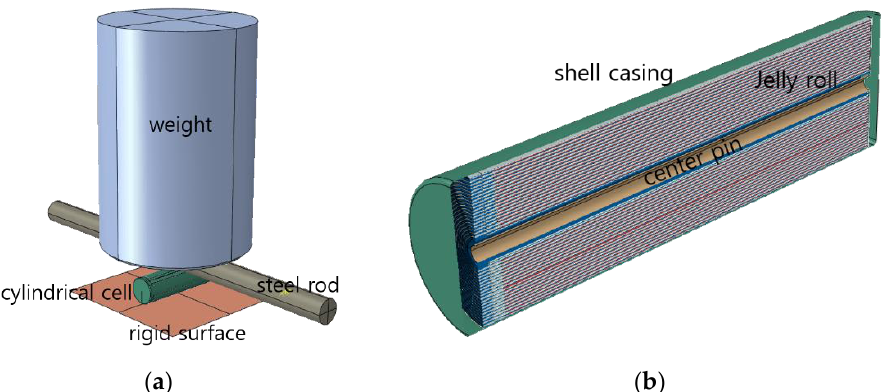
Figure 2. ( a ) Schematic of the impact test. ( b ) A cross-section view of a three-dimensional finite element model of a jelly roll, center-pin, and shell casing. Table 1. Material properties of cell